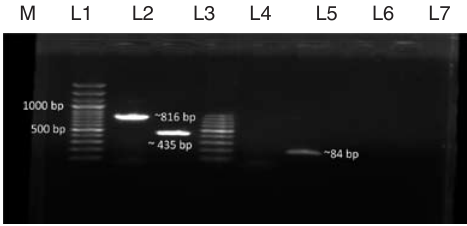
Fig.1 Agarose gel showing amplified product of Campylobacter genus and C